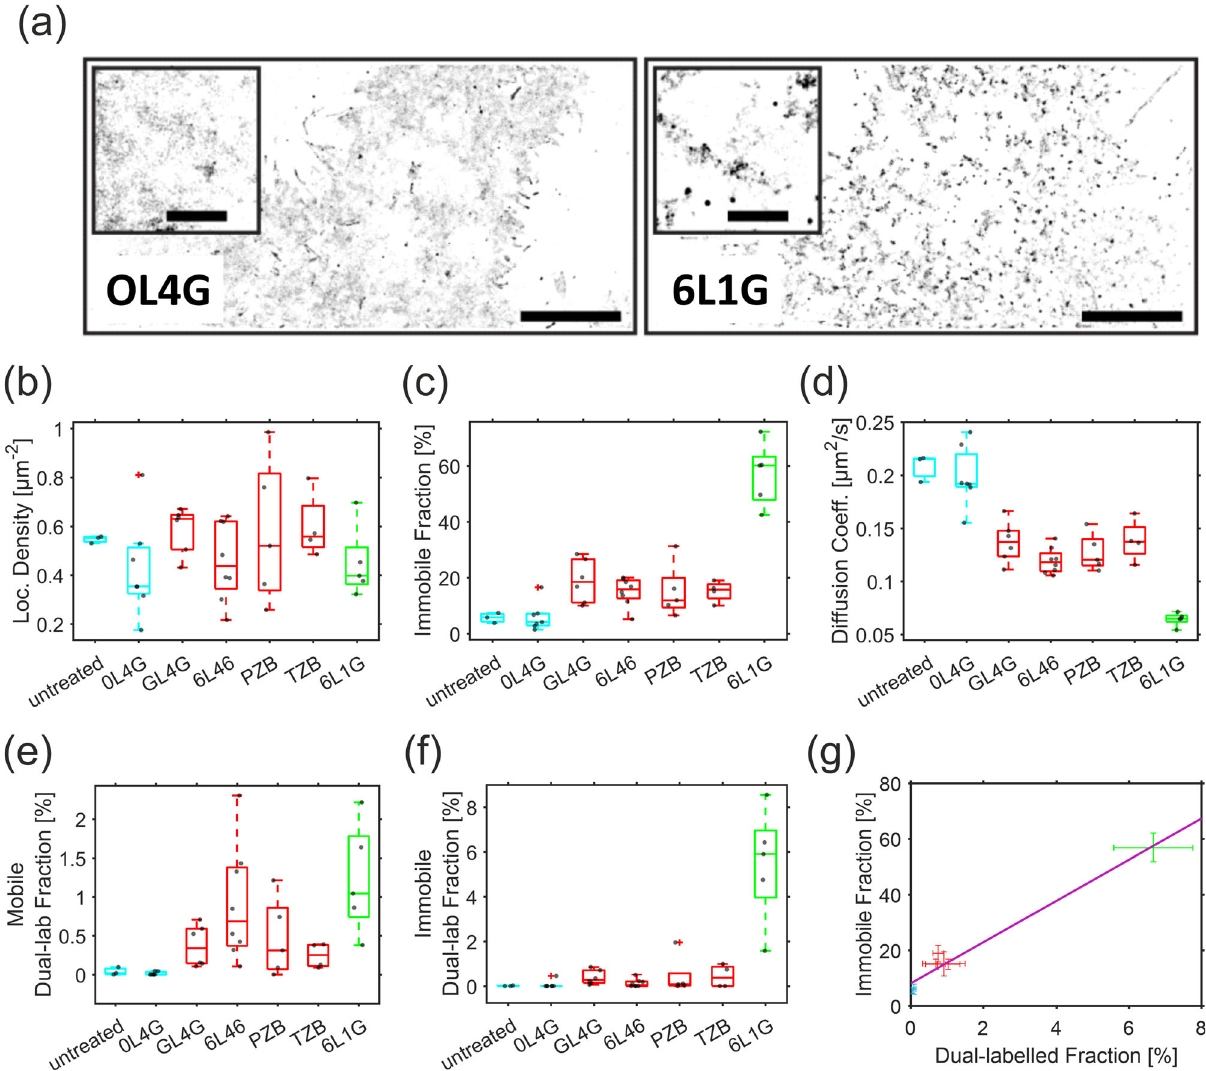
Fig. 6 Lockdown and oligomerization of HER2 diffusion as resolved by single-molecule localization microscopy. a Representative SMLM super- resolution images rendered from 500 consecutive frames (localization precision ~20 nm) with localization densities encoded as gray values. Scale bar: 10 µ m. Magni fi ed center regions are shown as insets (scale bar: 2 µ m). b Particle densities in the DY-649 channel observed in different single-molecule experiments. c , d Comparison of the immobile fraction identi fi ed by spatiotemporal clustering analysis ( c ) and the diffusion coef fi cient within the mobile fraction ( d ) for HER2 for different treatments. e , f Colocalized HER2 molecules in the mobile ( e ) and the immobile fraction ( f ) quanti fi ed by dual-color co- tracking. g Correlation of the total fraction of co-localized molecules with the immobile fraction and linear regression (R 2 = 0.97, Pearson ’ s r = 0.99, p = 3.5 × 10 − 5 ). Different colors (cyan, control or monovalent; red, homo-bivalent; green, biparatopic) in b – g indicate the three distinct groups of agents as referenced in the main text. The DARPins are shown schematically in Supplementary Fig. 1. Signi fi cance values for b – f are provided in Supplementary Fig.